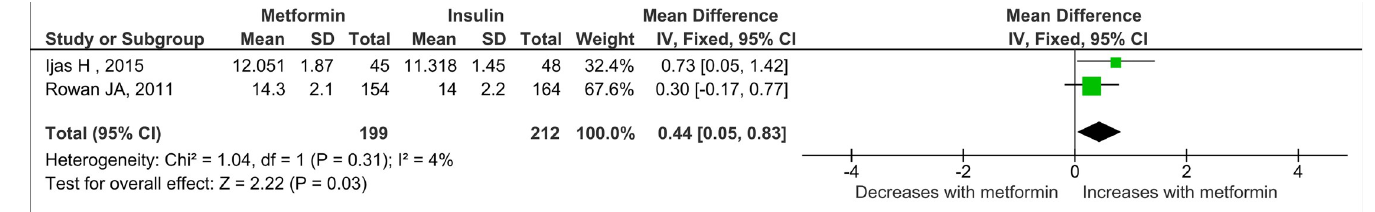
Fig 11. Infant weight. Expressed as mean differences (fixed effects model) and 95% CI. IV, mean difference.